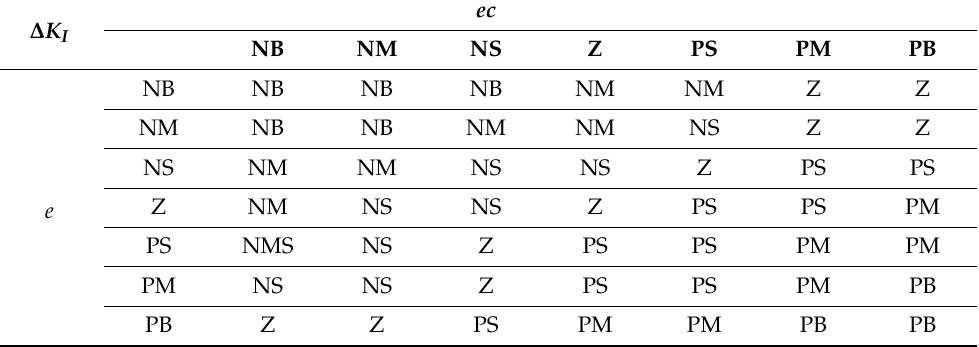
Table 2. Fuzzy control rules for ∆ K I .